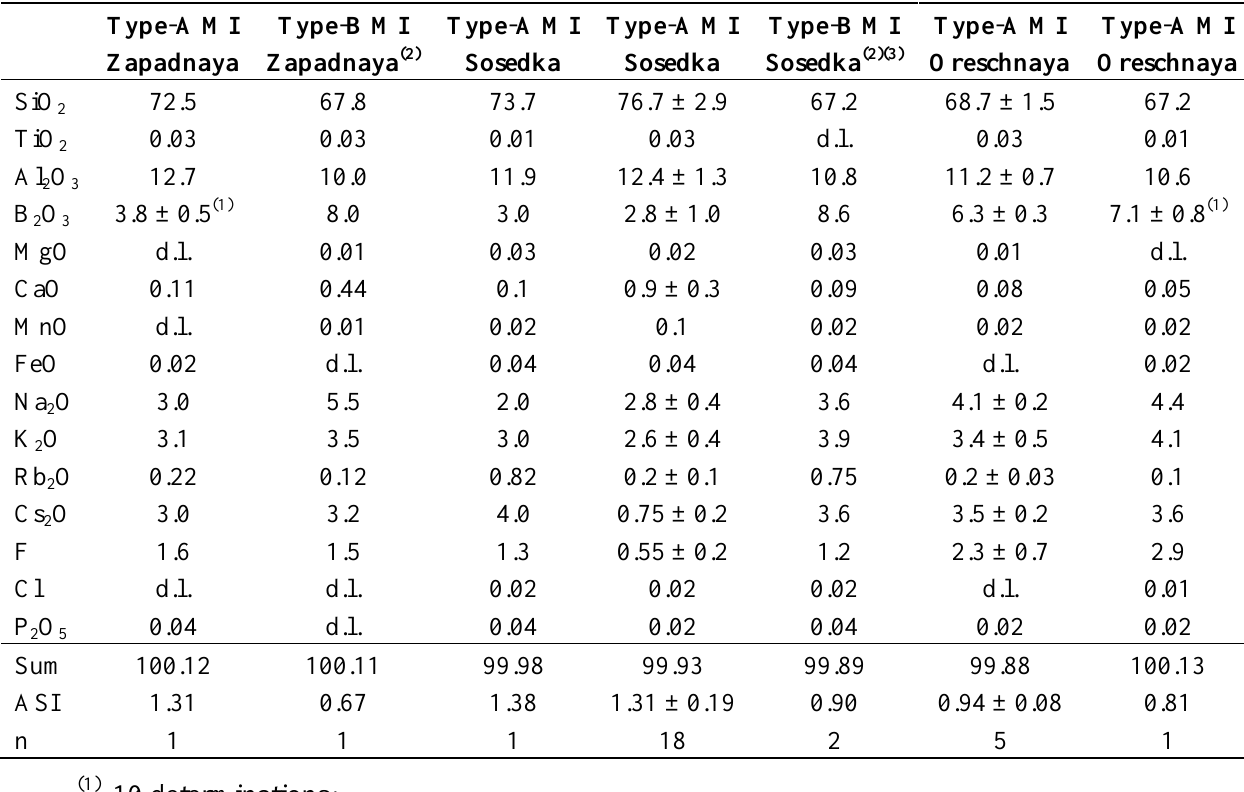
Table 3. Selected microprobe results on melt inclusions in quartz of graphic granite from the Malkhan pegmatites [data in % (g/g)],